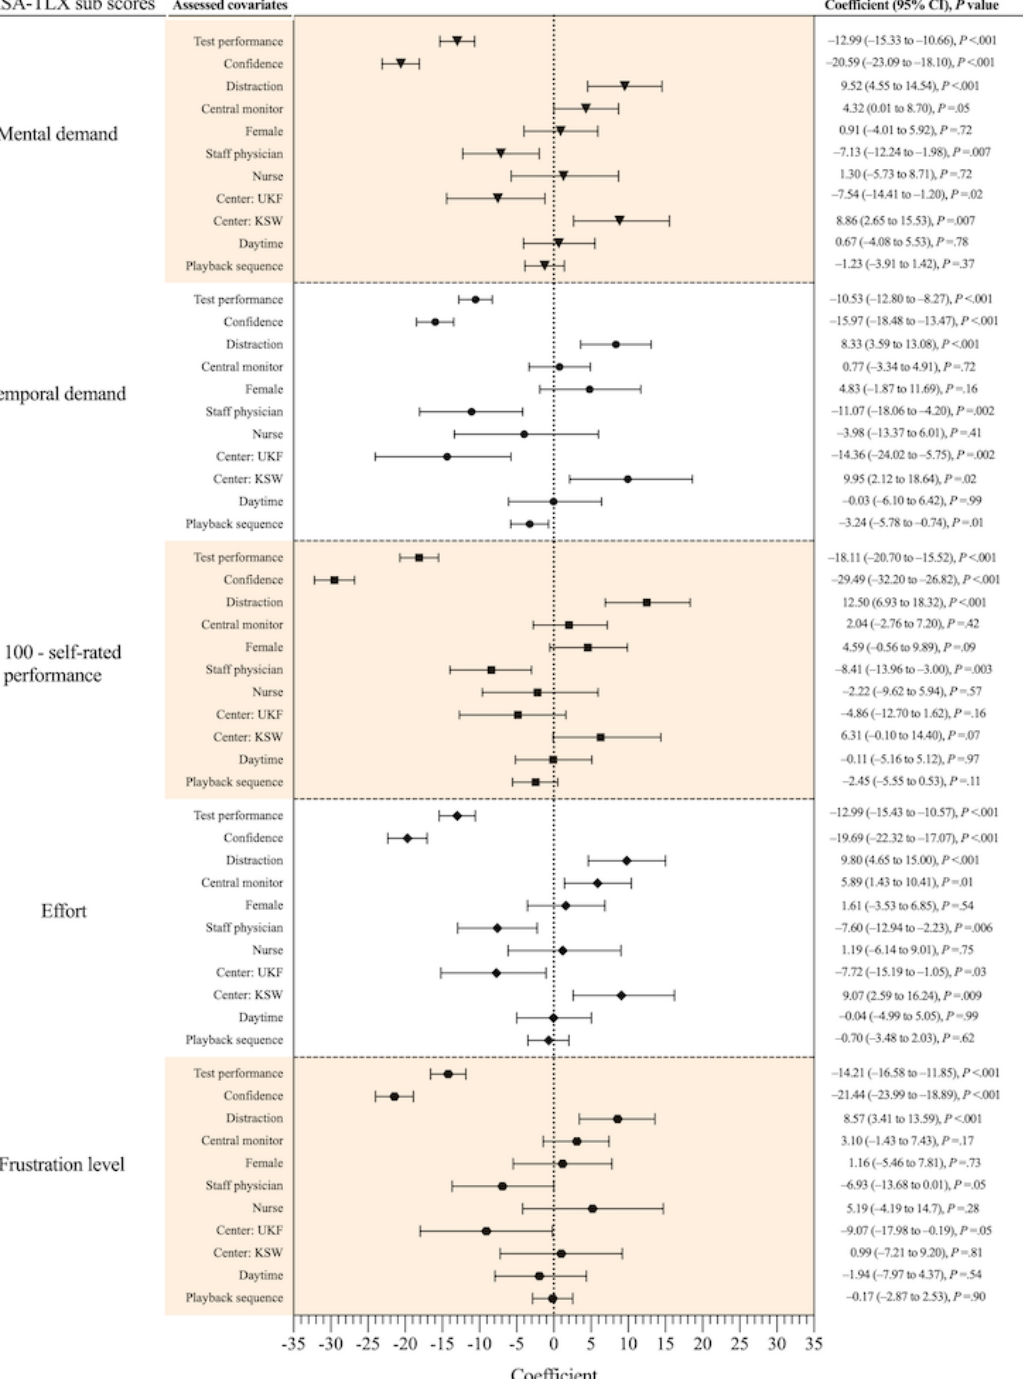
Figure 3. Correlation of different covariates with subscores of the National Aeronautics and Space Administration Task Load Index (NASA-TLX) workload assessment tool. The original NASA-TLX questionnaire evaluated performance on an inverted X-axis from perfect to failure, with a low raw score corresponding to good self-rated performance. Therefore, to ensure that the X-axis in this figure is the same, the self-rated performance is displayed inverted. KSW: Cantonal Hospital Winterthur; UKF: University Hospital